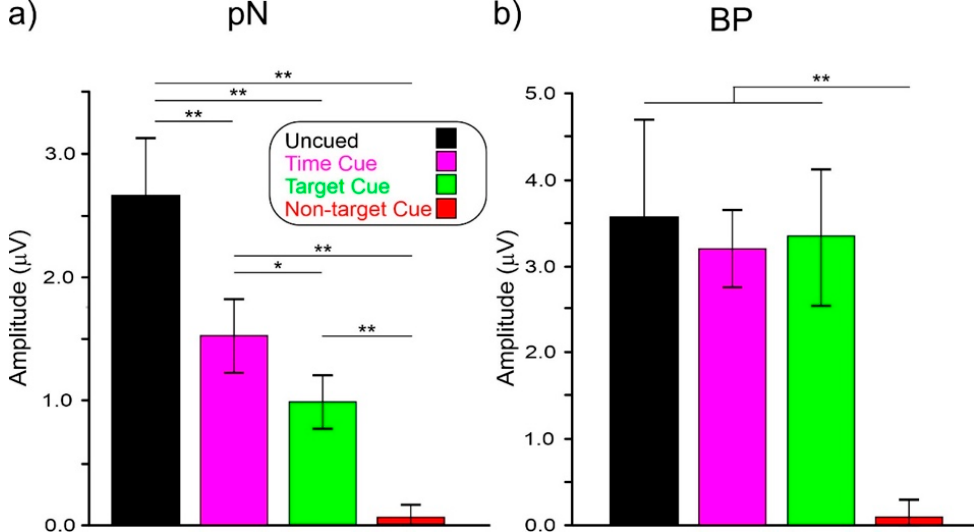
Figure 5. ( a ) Amplitudes of the pN and BP; ( b ) components in the − 800/0 ms interval in the four conditions. Vertical bars denote 0.95 confidence intervals. * p < 0.05, ** p < 0.01.